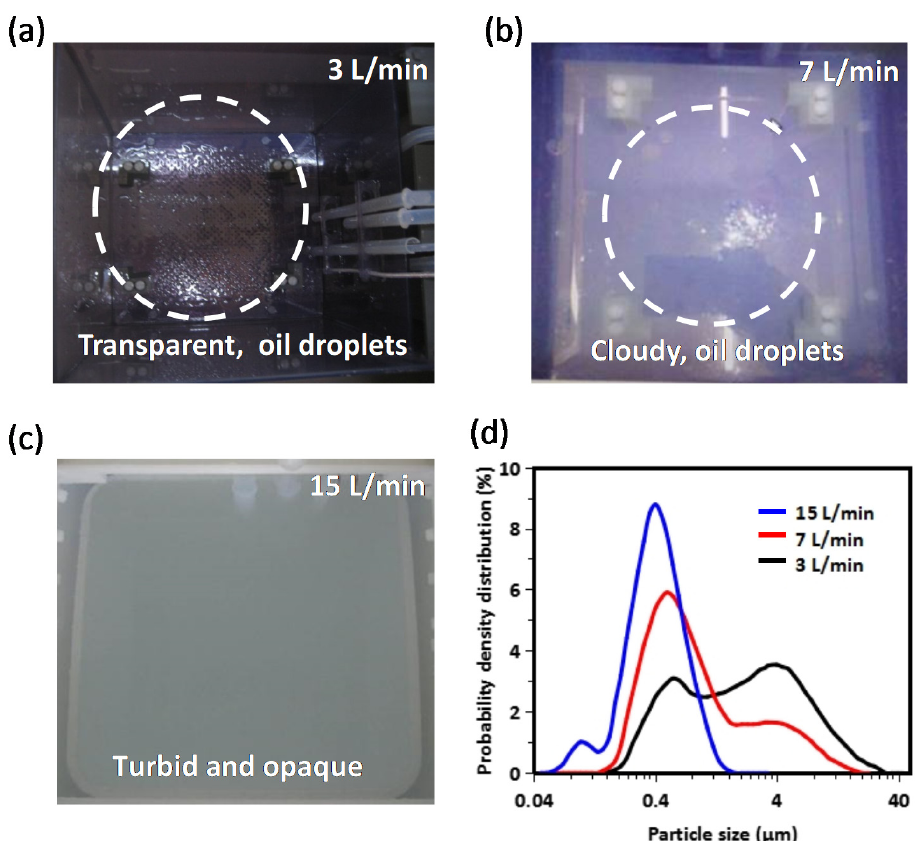
Figure 2. Optical photographs from the top of the solution of the additive under stirring conditions of ( a ) 3 L/min, ( b ) 7 L/min, ( c ) 15 L/min, and ( d ) the distribution of additive dispersed particles with the concentration of 1%.